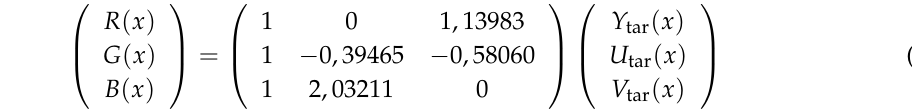
for all x . Figure 3 (Image segements with unified background of George W. Bush ∈ G